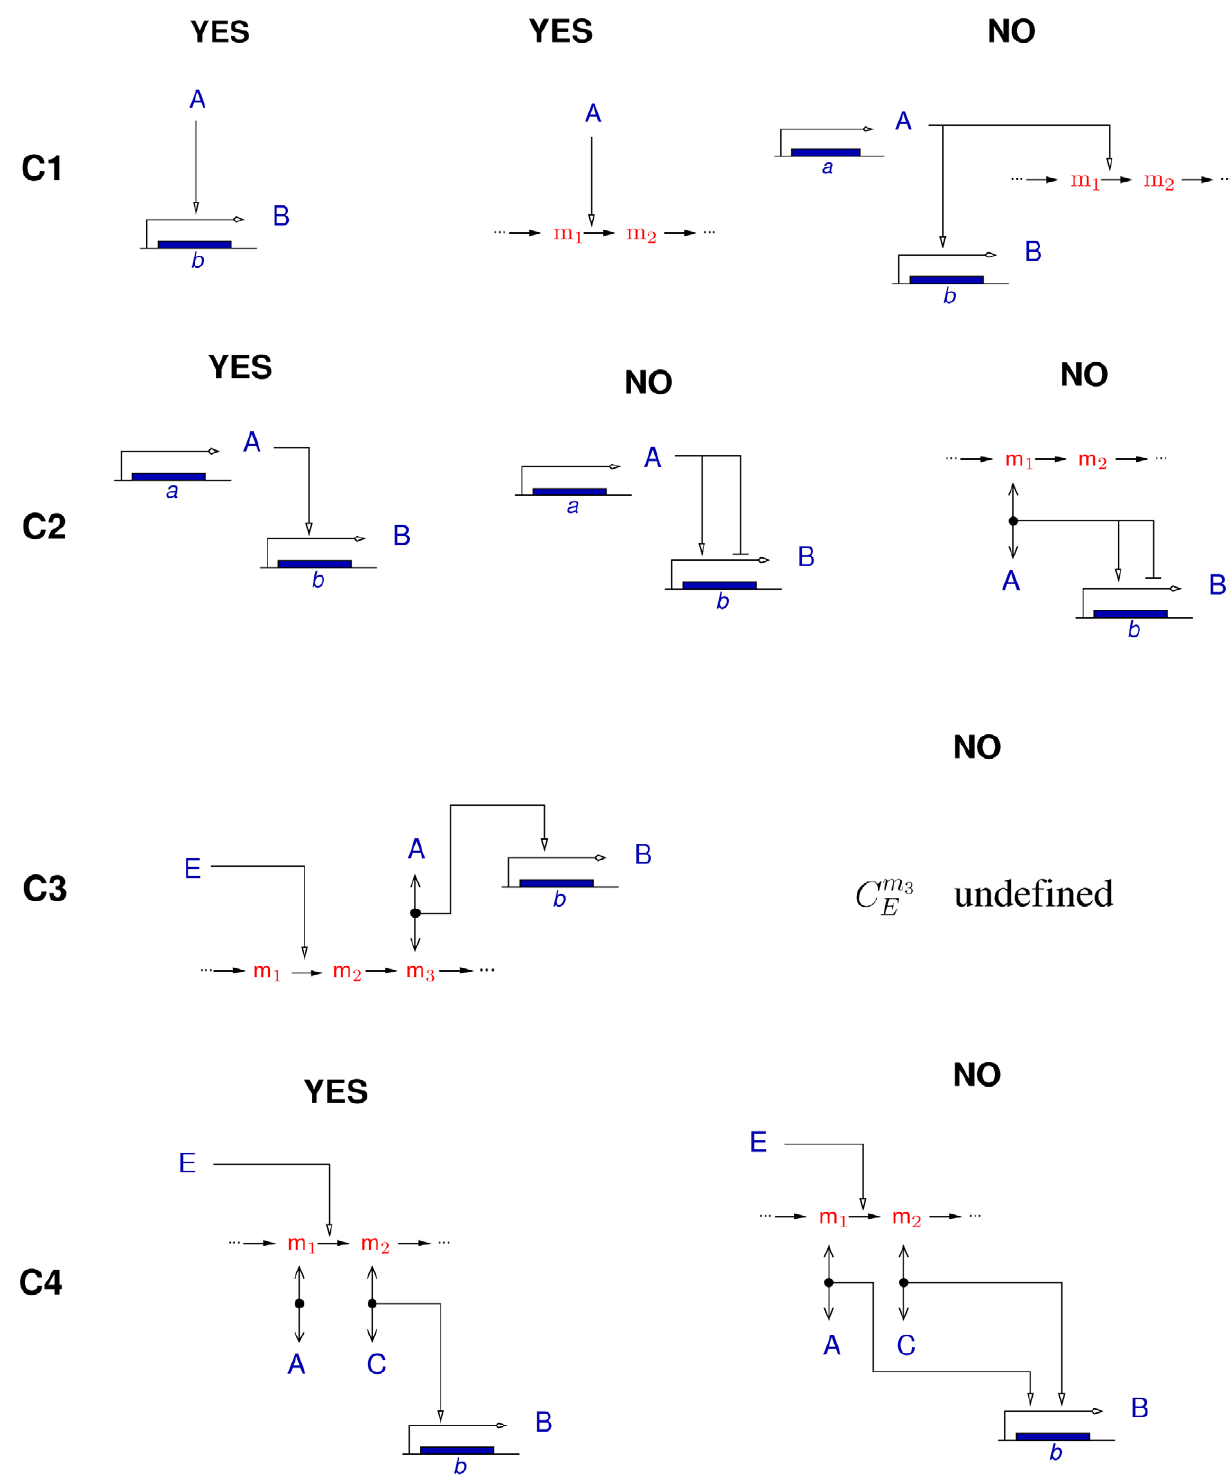
Figure 2. Schematic illustration of the four sufficient conditions for sign determinedness, C1–C4. The conditions are explained by means of example patterns that are either allowed or forbidden. Notice that the above examples are not meant to be exhaustive; their aim is simply to clarify the consequences of C1 – C4 on a few concrete cases. In the examples, A, B, C, and E are proteins, while m 1 , m 2 , and m 3 are metabolites. C m 3